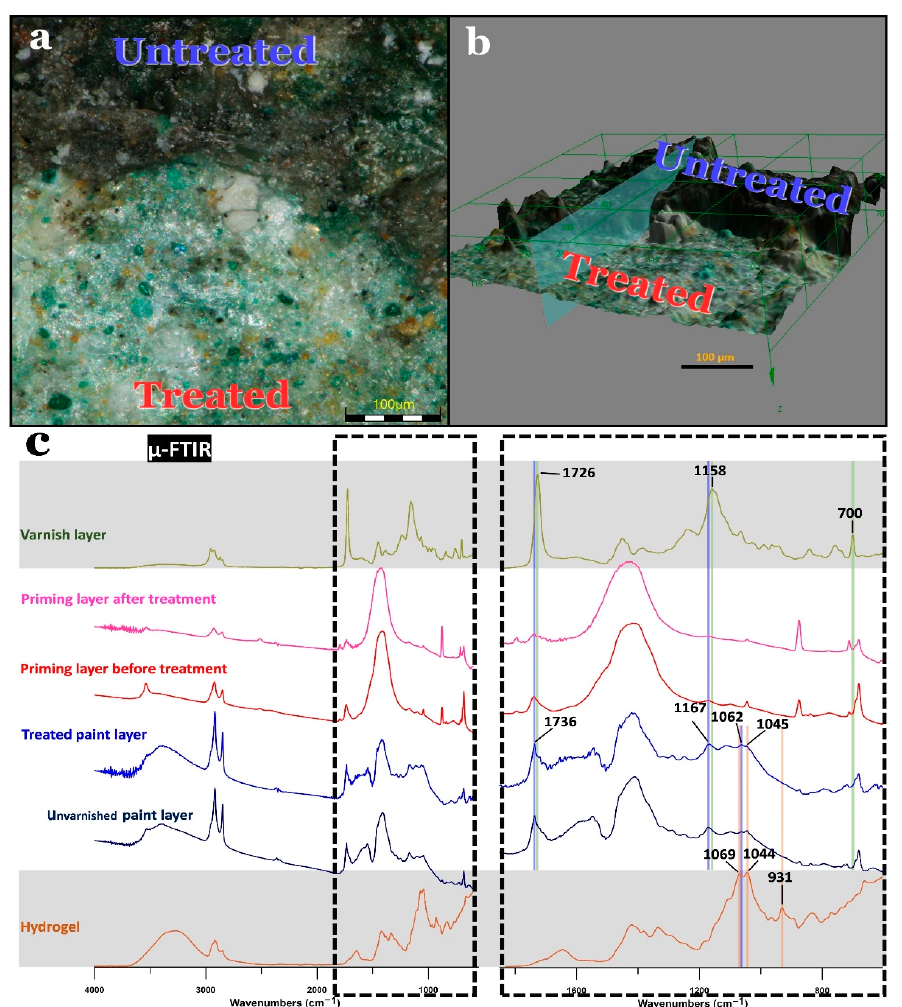
Figure 10. ( a ) Photomicrograph showing the boundary between a treated and an untreated area of a green area of the wall painting. The untreated area shows the darkened varnish layer, while the treated area illustrates the total removal of the varnish layer, revealing the original color of the surface. ( b ) 3D photomicrograph of the same view revealing the presence of a thick, darkened varnish layer. ( c ) µ-FTIR spectra of the varnish, priming coat before and after the treatment, treated and nontreated paint layers, and hydrogel.